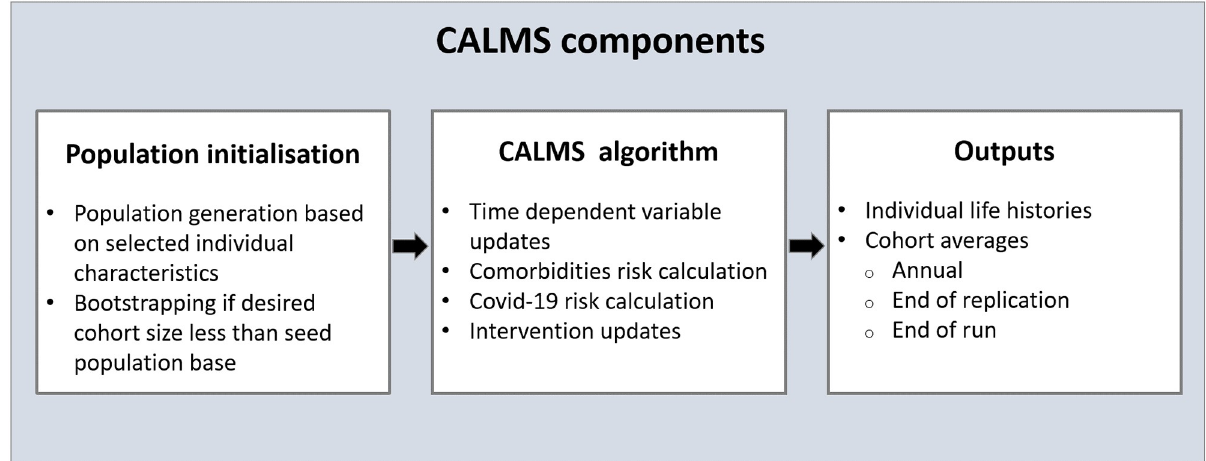
Fig 1. CALMS high level